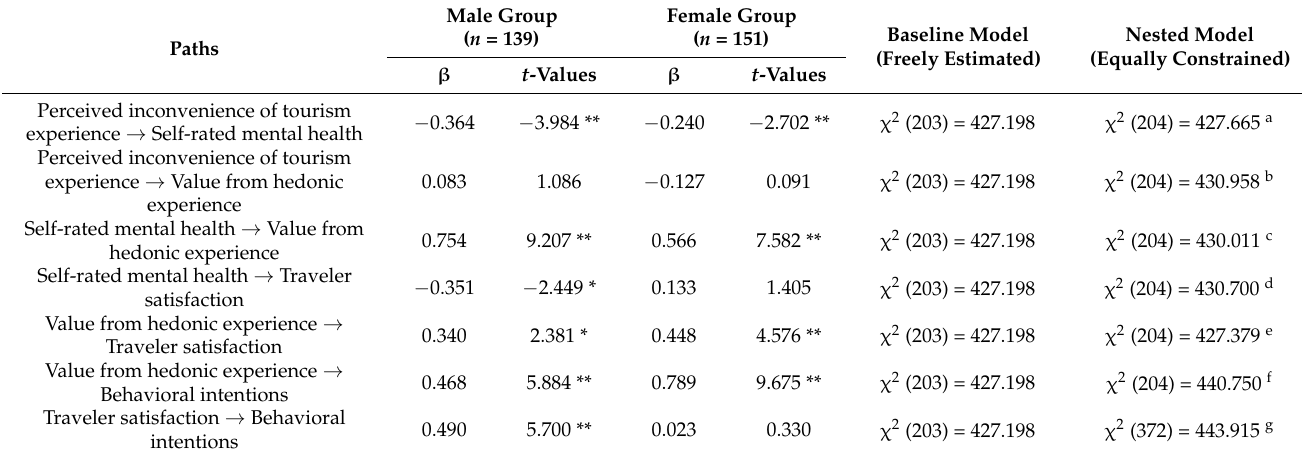
Table 3. The invariance model assessment for gender groups.